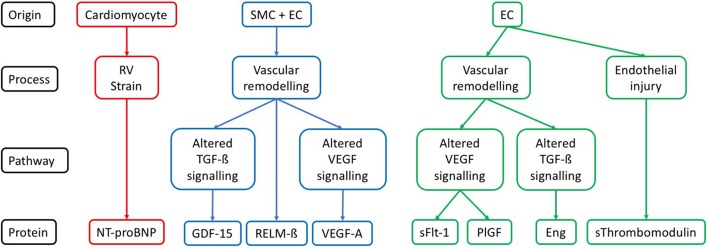
Cellular origin and pathways for each protein described in the context of SSc-PAH. Description of the likely origin of each protein, along with the pathophysiological process it has a role in. If a component of one of the pathways known to be relevant to pathogenesis of PAH then this is also given. SMC, vascular smooth muscle cell; EC, vascular endothelial cell; RV, right ventricle; TGF-ß, transforming growth factor beta; VEGF, vascular endothelial growth factor; NT-proBNP, N-terminal pro-brain natriuretic peptide; GDF-15, growth differentiation factor-15; RELM-ß, resistin-like molecule beta; VEGF-A, vascular endothelial growth factor A; sFLT-1, soluble vascular endothelial growth factor receptor 1; PlGF, placenta growth factor; Eng, endoglin; sThrombomodulin, soluble thrombomodulin.